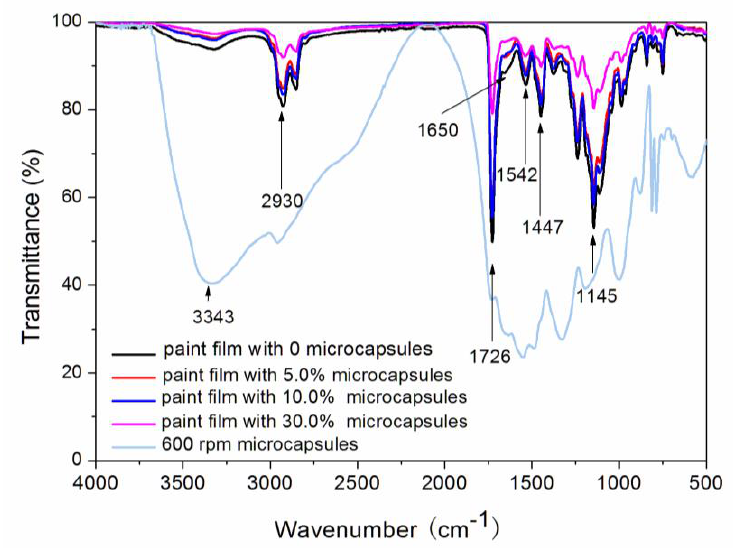
Figure 13. The infrared spectrum of water-based paint film with different microcapsule mass fractions.